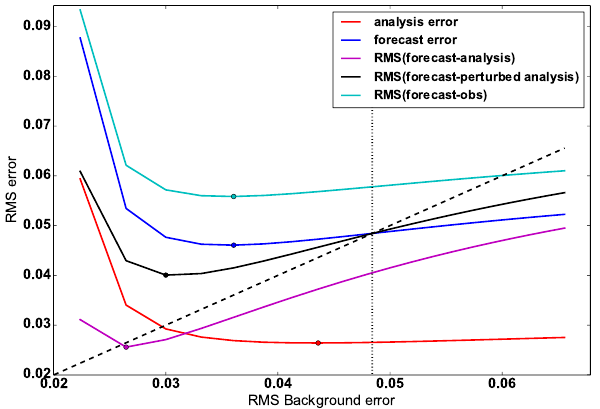
Figure 1. RMS error of the forecast and analysis using the logis- tic model as a function of the background error standard devia- tion used in calculating the analysis. The red and blue lines show the RMSE for the analysis and forecast measured against the truth state. The other lines show the RMSE of the forecast, when verified against a different proxy for the truth. Verification is calculated over 200000 analysis and forecast